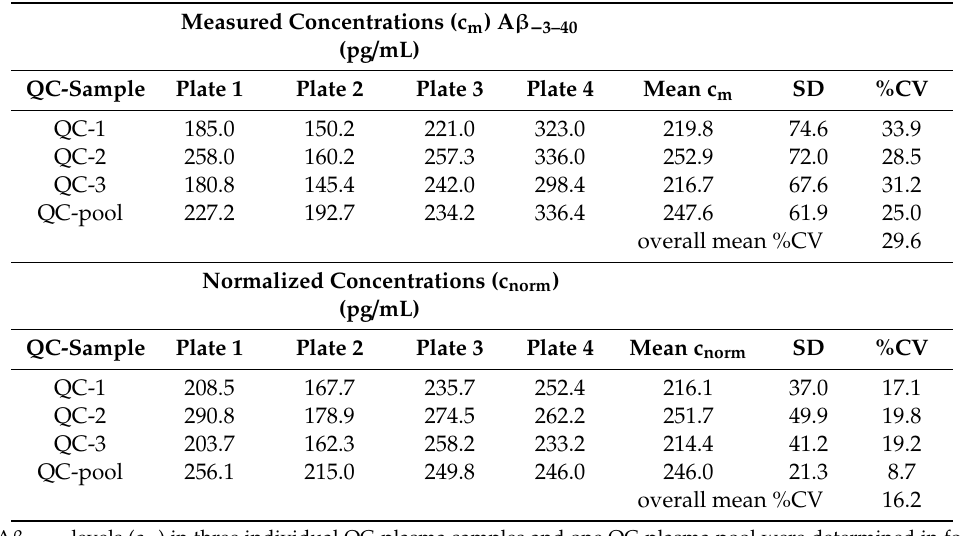
Table 8. Intermediate imprecision of the two-step immunoassay and normalization